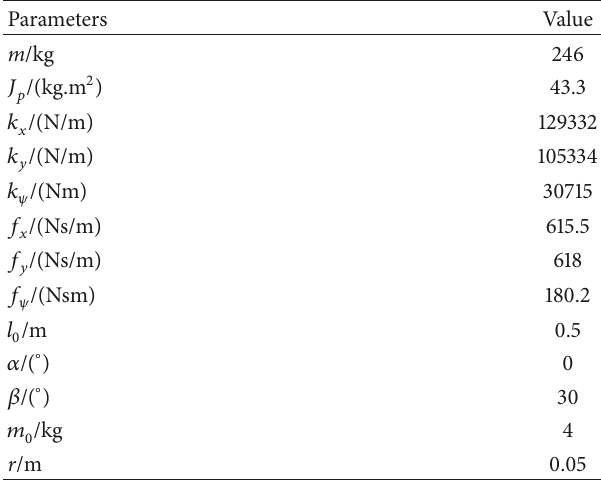
Table 2: Parameters of the vibration